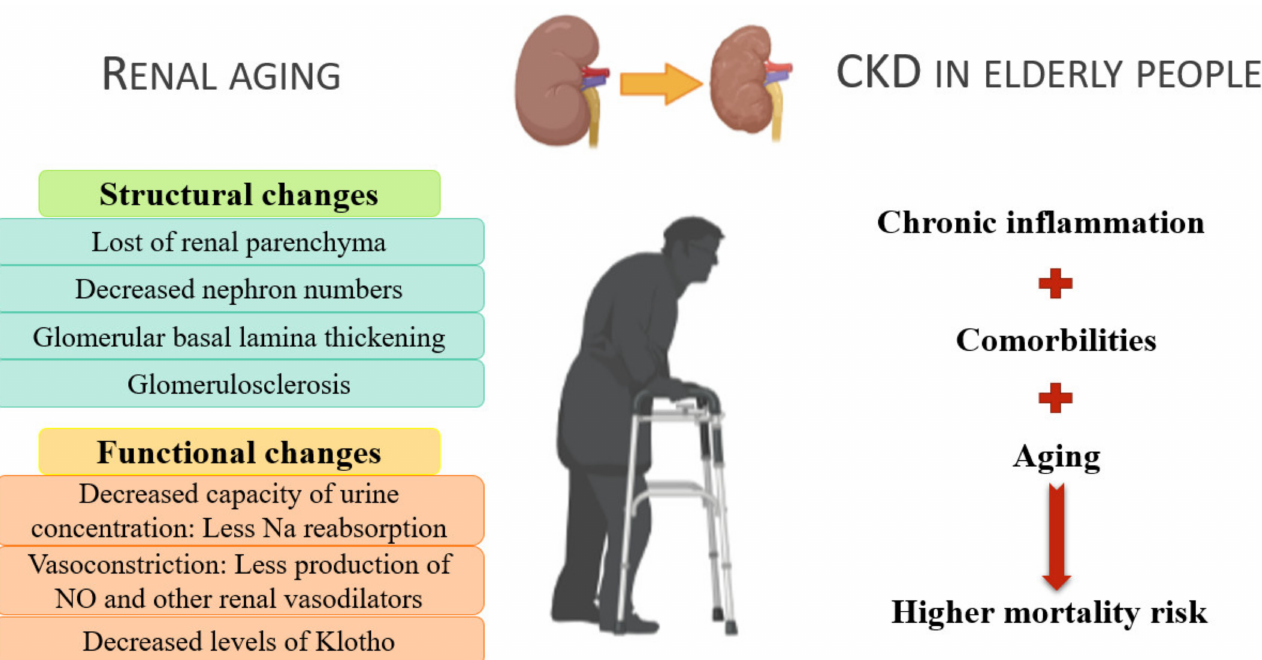
Figure 2. Renal aging and the consequences of chronic kidney disease in elderly